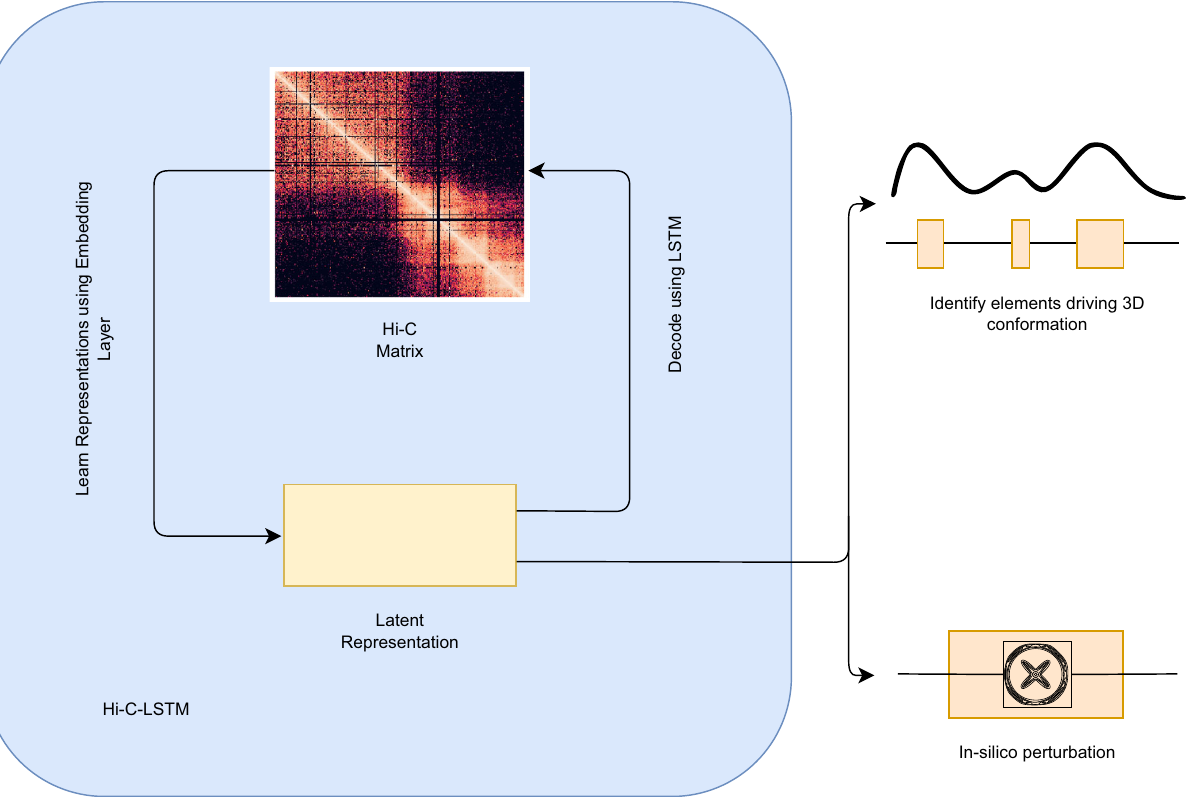
Fig. 1 Overview of approach. Hi-C-LSTM learns a K -length vector representation of each genomic position that summarizes its chromatin contacts, using an LSTM embedding neural network. The representations and LSTM decoder are jointly optimized to maximize the accuracy with which the decoder can reproduce the observed Hi-C matrix given just the representations. The resulting representations identify sequence elements driving 3D conformation through integrated gradients (IG) analysis, and they enable a researcher to perform in-silico perturbation experiments by editing the representations and observing the effect on predicted